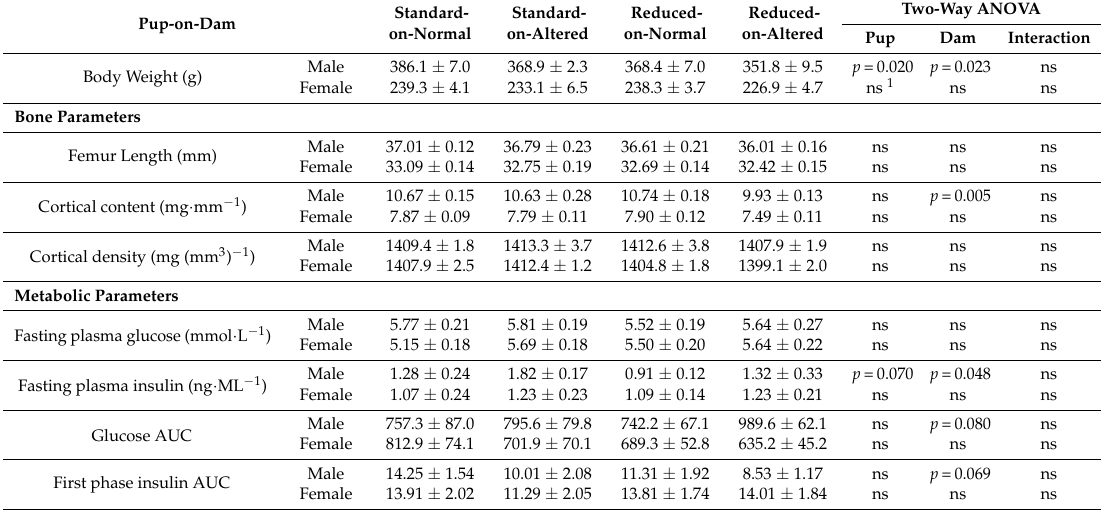
Table 4. Adult offspring physiology in the four cross-foster groups at 6 months ( n = 9–19 per group for bone analyses and n = 5–11 per group for cardiometabolic analyses, with n = 1 representing 1 male and female per